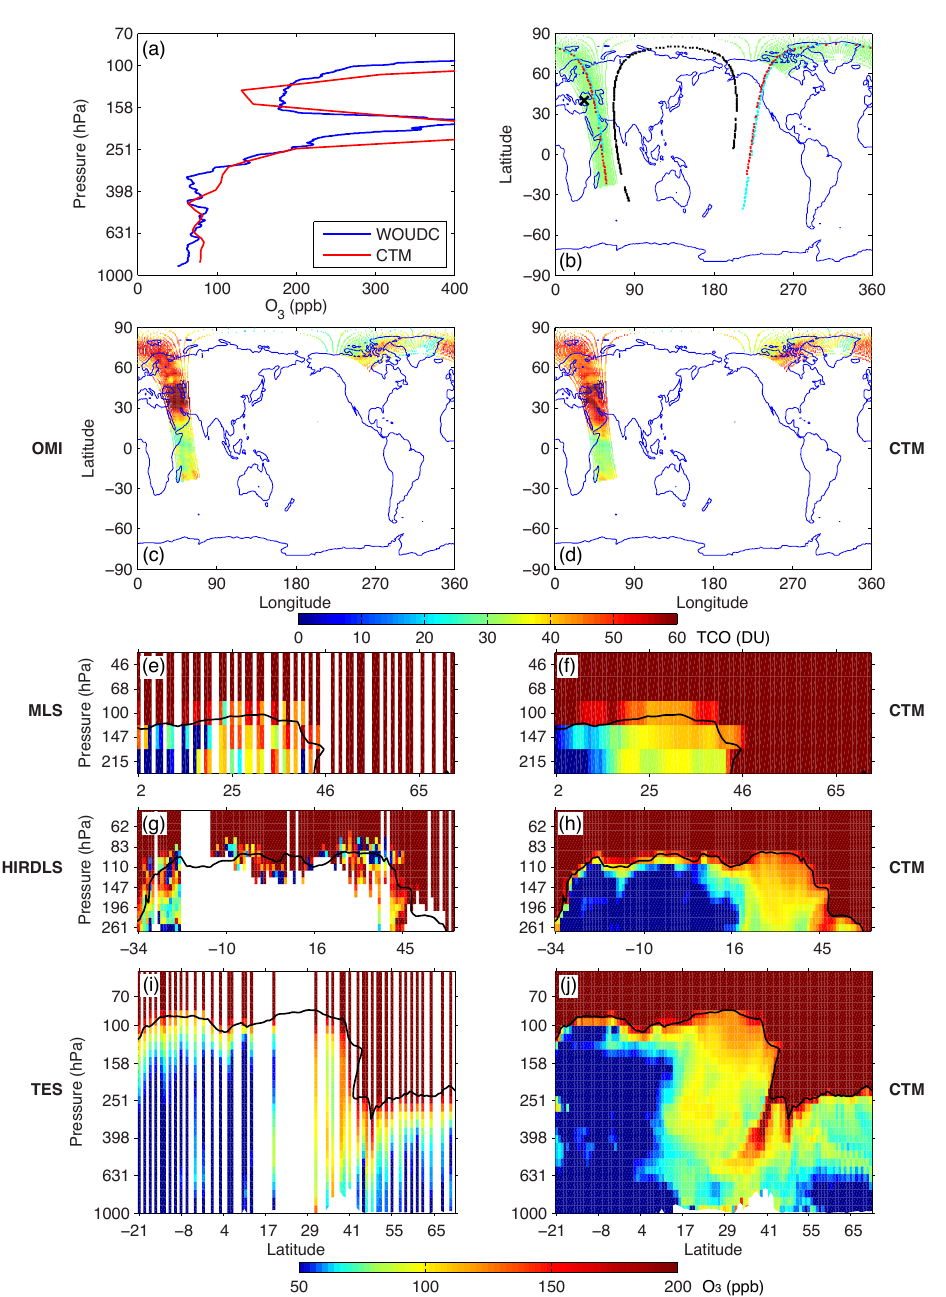
Fig. A2. Same as Fig. 3 for 6 July 2005. The sonde is from Ankara (40.0 ◦ N, 32.9 ◦ E, station code 348) at 11:52UTC, compared with model simulation at 12:00UTC in (a) . The Aura and CTM swaths are for 10:00–11:00UTC. (c) – (j) show the swaths in 0 ◦ –134 ◦